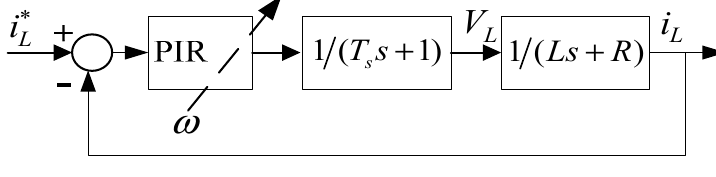
Figure 8. The self-adaptive current loop.